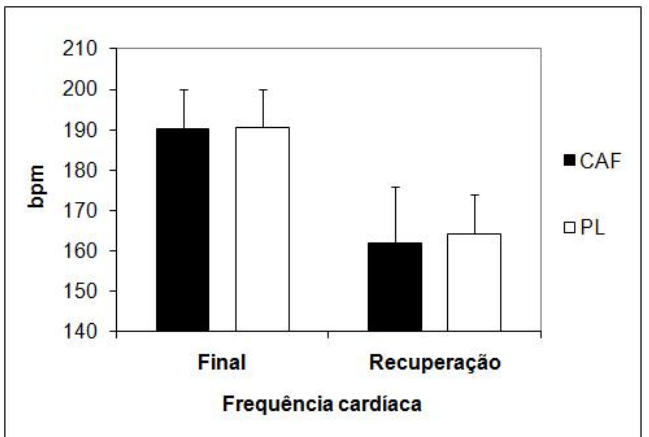
Figura 3. Resposta da frequência cardíaca imediatamente após a execução do Special Judo Fitness Test e após 1 minuto de recuperação.